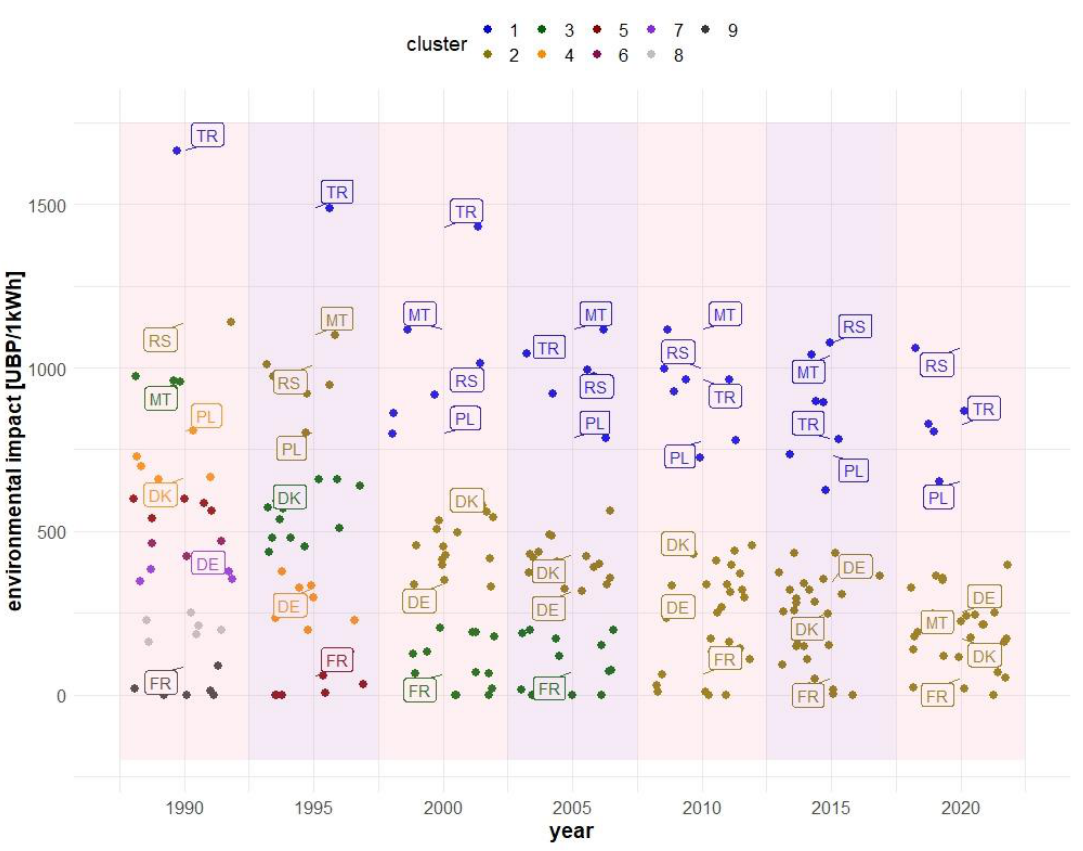
Figure 5. The level of environmental impact of electricity production in Europe in the period of 1990 – 2020 [UBP/1 kWh].